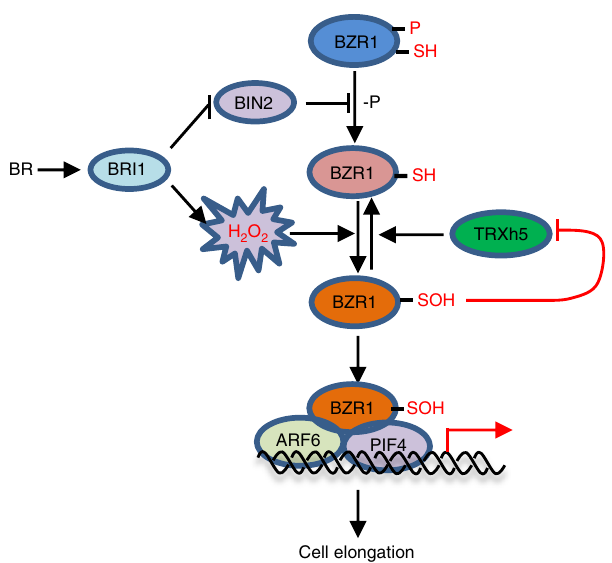
Fig. 7 A model for the regulatory network integrating BR and H 2 O 2 signals in cell elongation. Binding of BR to receptor kinase BRI1 not only inhibits the kinase activity of BIN2 to promote dephosphorylation of BZR1, but also increases cellular level of H 2 O 2 , which causes oxidation of BZR1 at a conserved cysteine residue. This oxidation enhances BZR1 transcriptional activity by promoting its interaction with partners, such as ARF6 and PIF4. The oxidized BZR1 is reduced by thioredoxin TRXh5. As the level of H 2 O 2 and TRXh5 activity can be altered by many signals, such redox regulation of BZR1 plays an important role in fi ne-tuning BR responses by additional